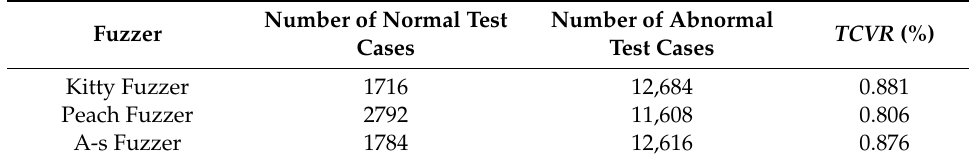
Table 3. Statistical table of the variation rate of all the test cases of the three fuzzers. TCVR , test case variation rate. Number of Normal Test Number of Abnormal TCVR (%) Fuzzer Cases Test Cases